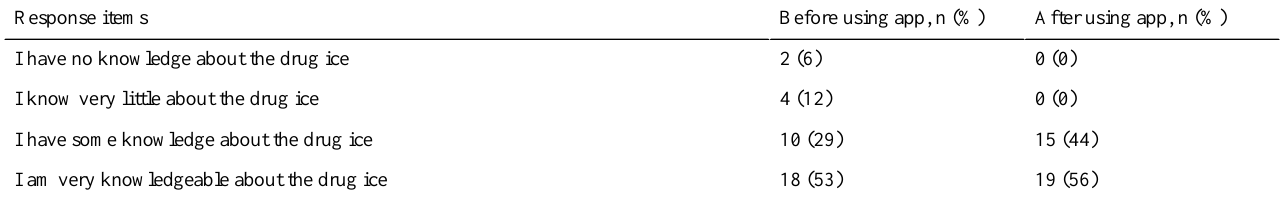
Table 3. The frequency and proportion of respondents endorsing knowledge items before and after using app